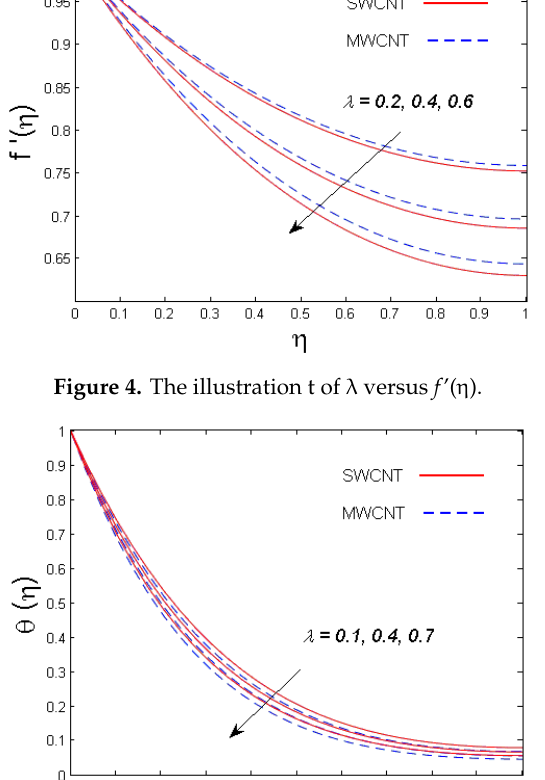
Figure 5. The illustration t of λ versus θ(η).